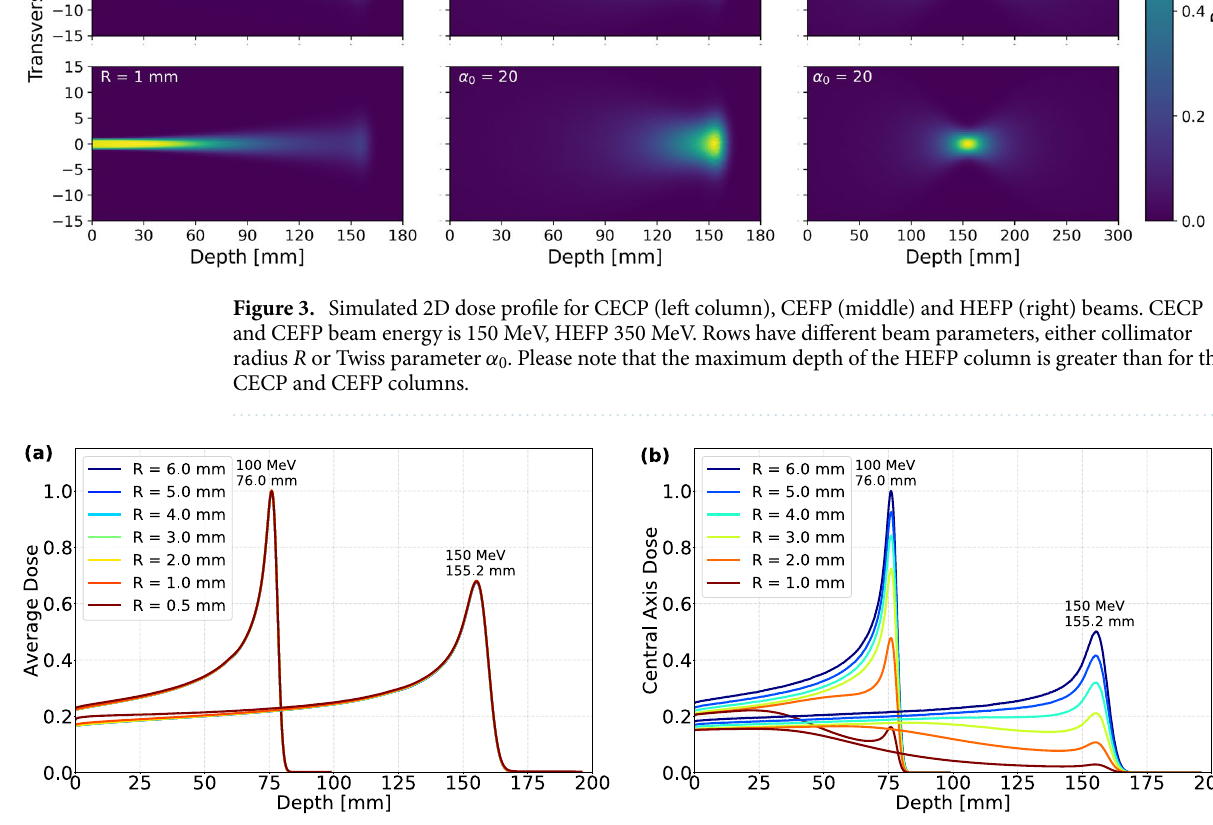
target for various collimator radii. This shows that the spot size at the target depends on the depth of the target. Furthermore, the small initial transverse beam size from a narrow collimator opening is not conserved at the Bragg peak.